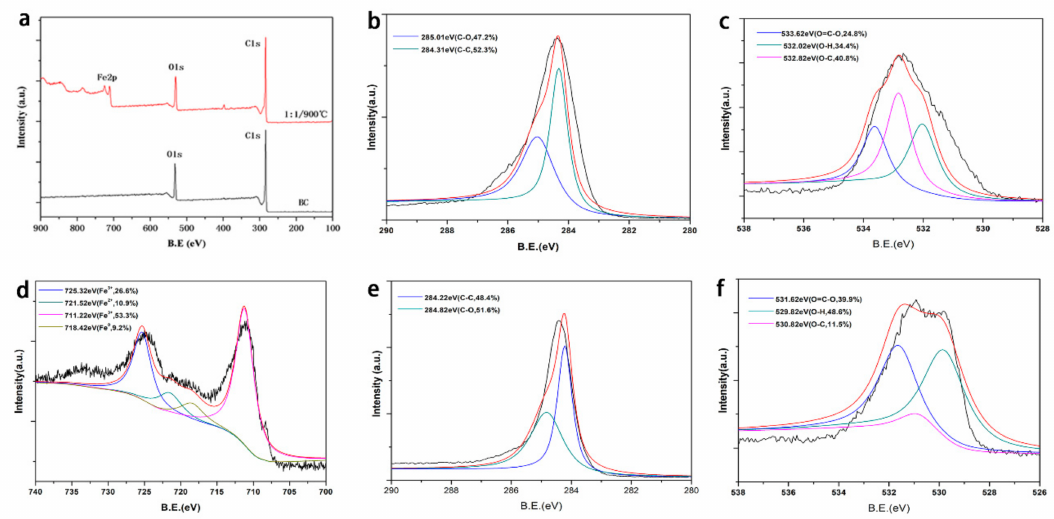
Figure 3. ( a ) XPS wide-scan; ( b ) C1s XPS spectra of BC; ( c ) O1s XPS spectra of BC; ( d ) Fe2p XPS spectra of 1:1 / 900 ◦ C; ( e ) C1s XPS spectra of 1:1 / 900 ◦ C; ( f ) O1s XPS spectra of 1:1 / 900 ◦ C.